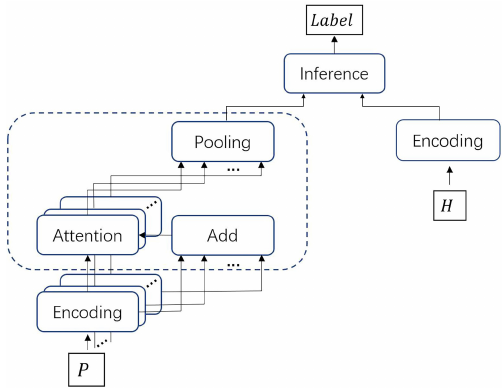
Figure 5. Attention-backtracking